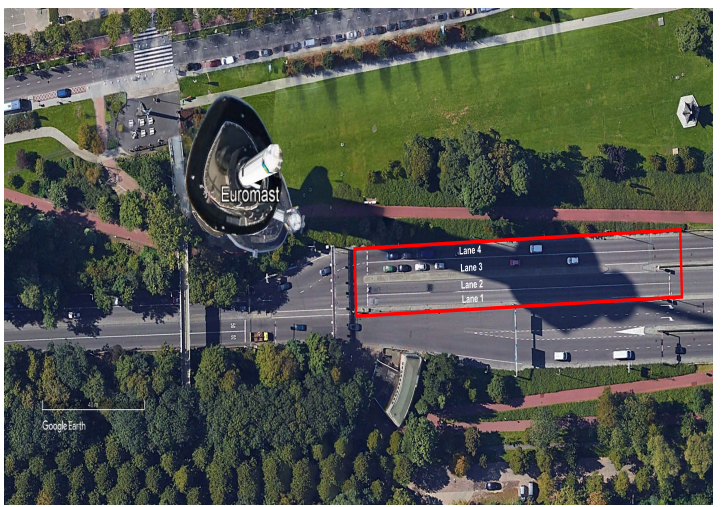
Figure 5. The area of Euromast tower and the signalised segment where data was collected. (Source: Google